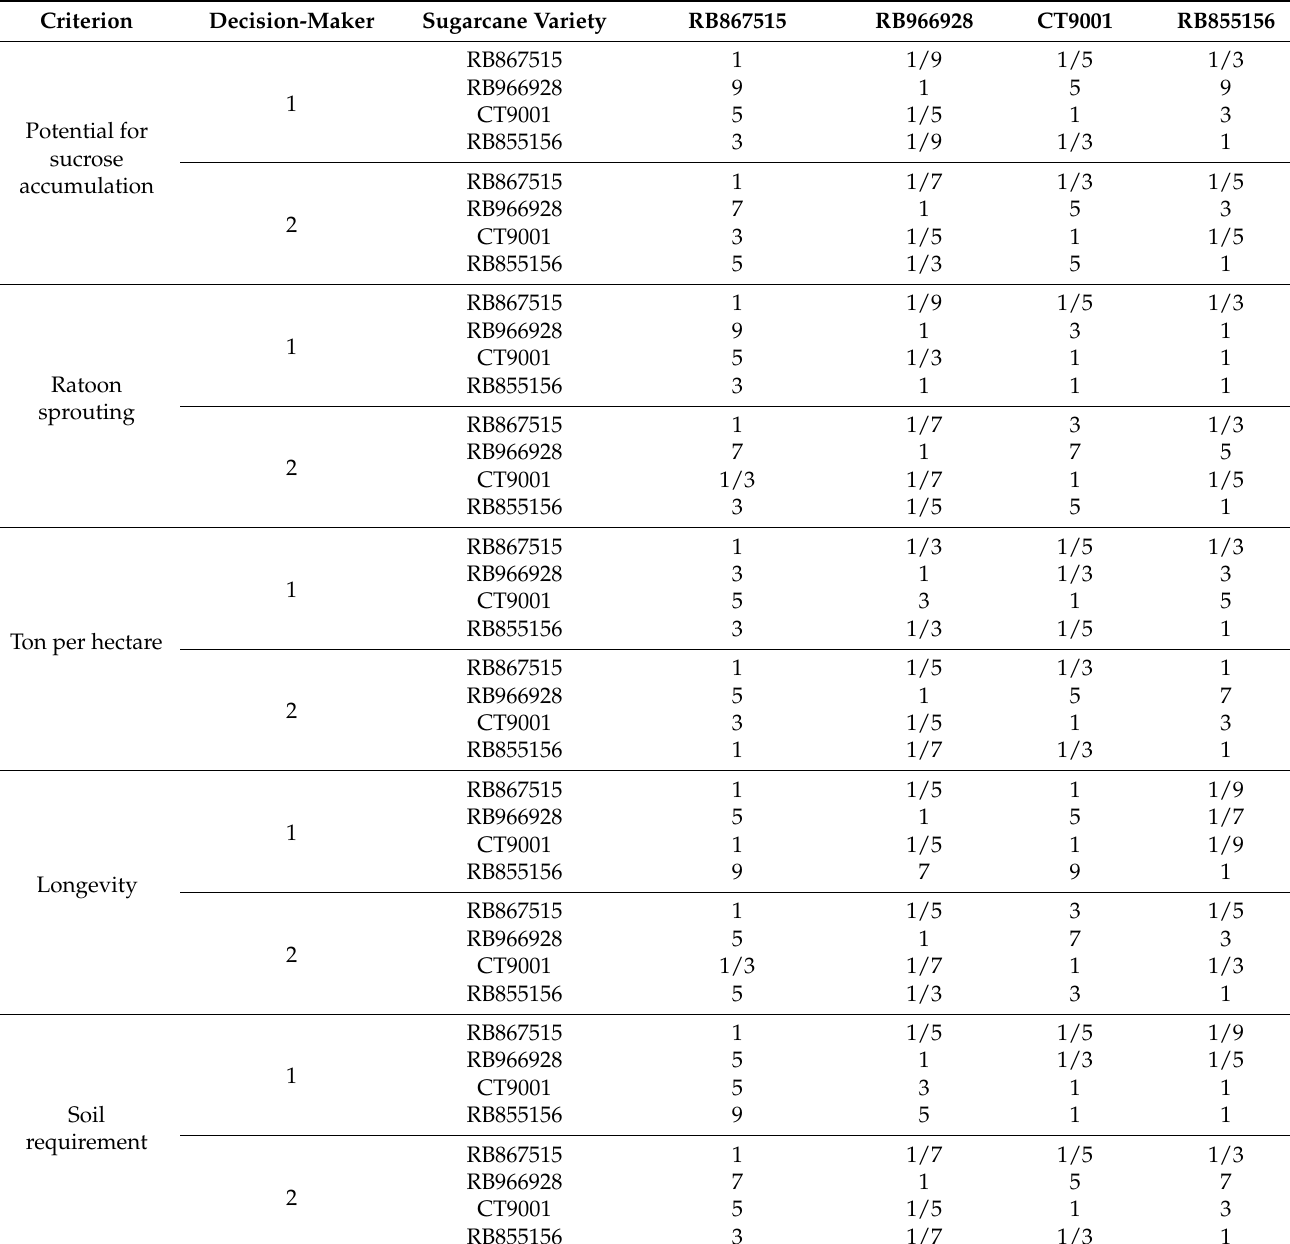
Table 2. Prioritization of each alternative of decision-maker 1 and decision-maker 2 for the variables considered in the AHP